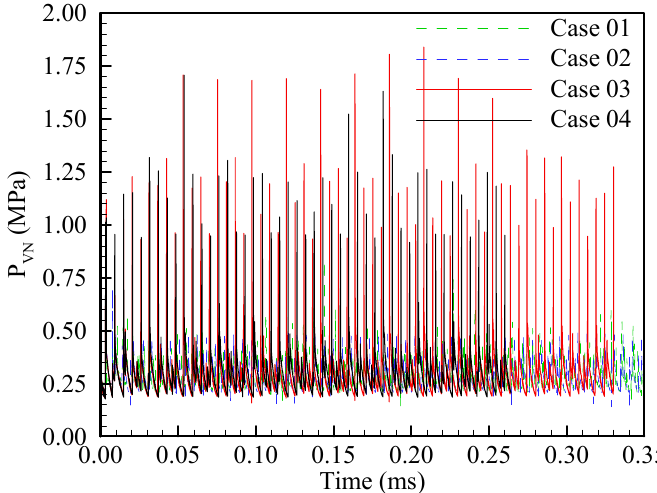
Figure 7. Grid refinement study using post shock VN pressure.